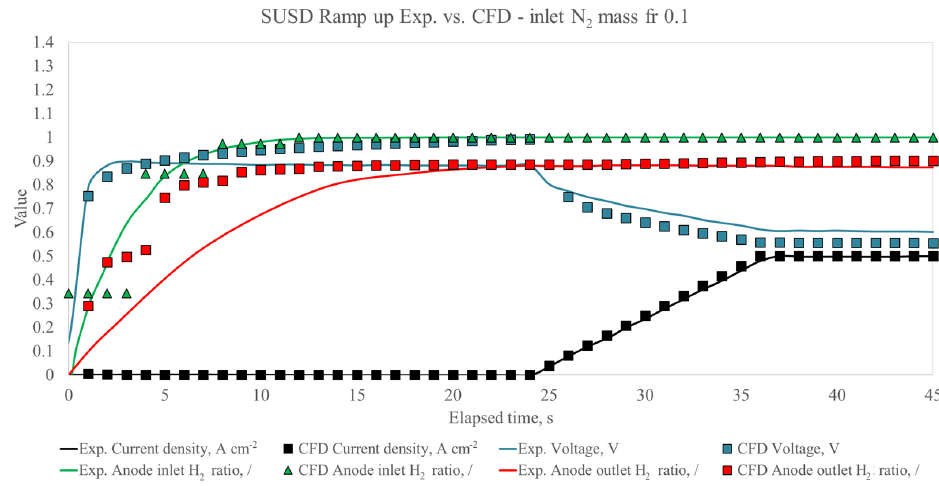
Figure 6. Comparison of experimental data vs. simulation results.